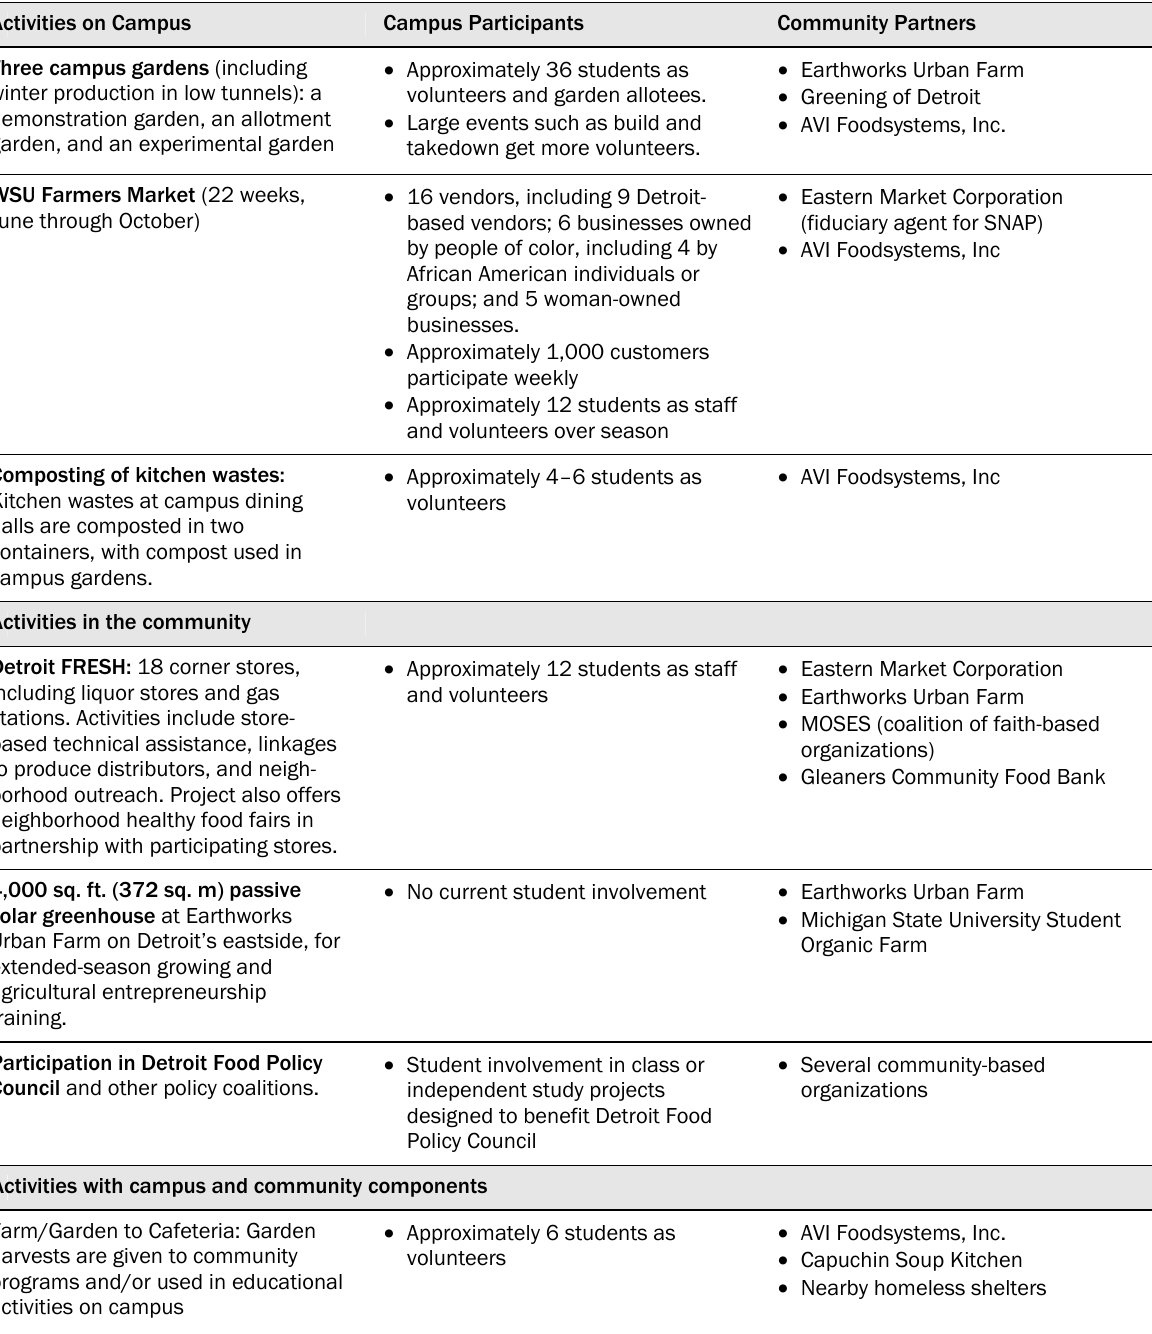
Table 1. SEED Wayne Activities on Campus and in the Community Activities on